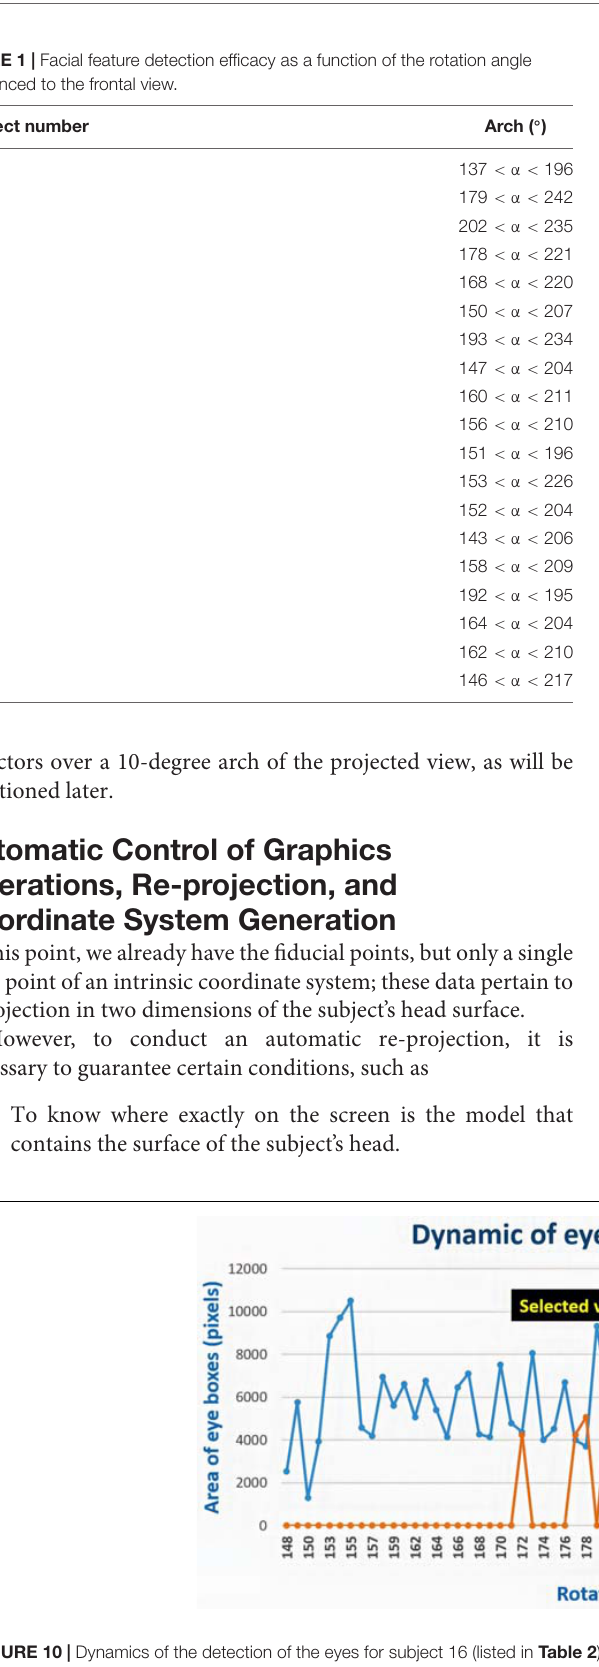
FIGURE 10 | Dynamics of the detection of the eyes for subject 16 (listed in Table 2 ) showing the eye box area vs. the rotation angle.